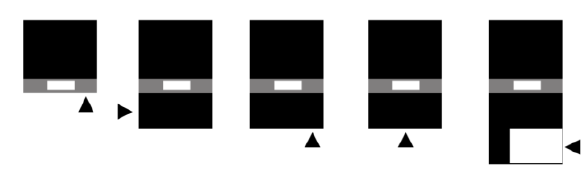
Figure 5. The mode chart of the one-step courtyards